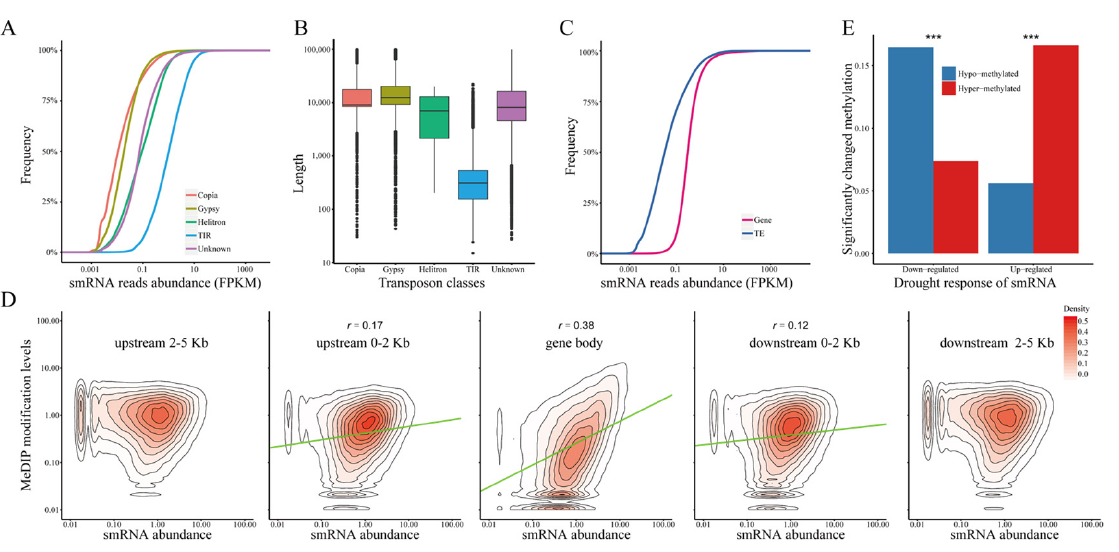
Figure 6. The closed relationship between small interfering RNA (siRNA) expression and DNA methylation. The distribu- tion of siRNA expression ( A ) and length ( B ) among varying classes of TEs. ( C ) The expression level of siRNA in genes and TEs. ( D ) The correlation of siRNA expression ( x -axis) and DNA methylation level ( y -axis) in different regions. The green lines fit the regression between siRNA abundance and DNA methylation level by genear linear model. ( E ) The proportion of up-/down-regulated siRNA in hyper-DMRs or hypo-DMRs under WS. ***: p < 0.001, χ 2